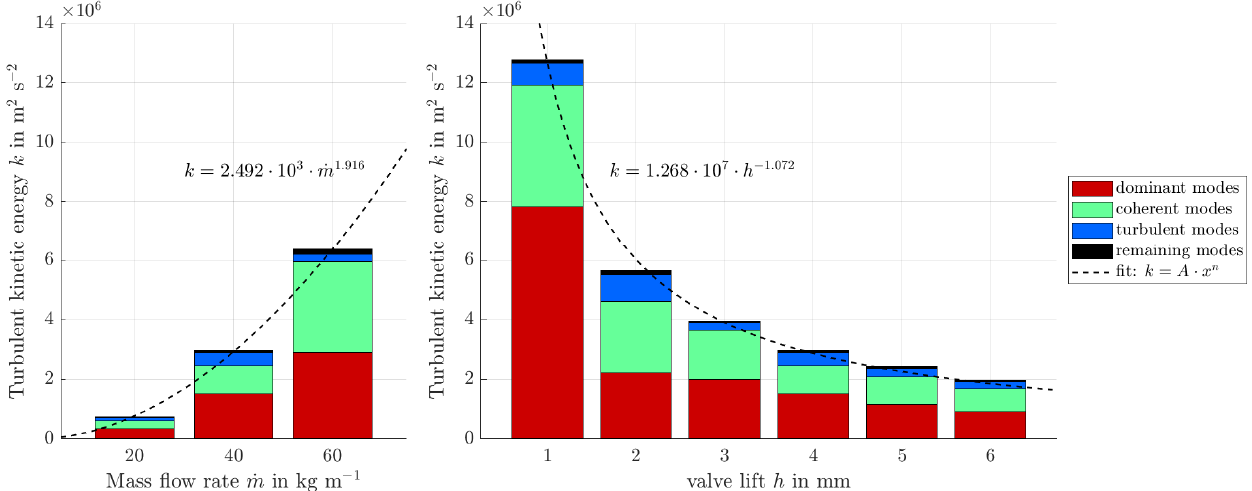
Figure 19. Amount of energy within the dominant, coherent, turbulent, and remaining modes for the PIV result of the mass flow variation at 4 mm valve lift ( left ) and the valve lift variation at 39.6 kg/h mass flow rate ( right ).